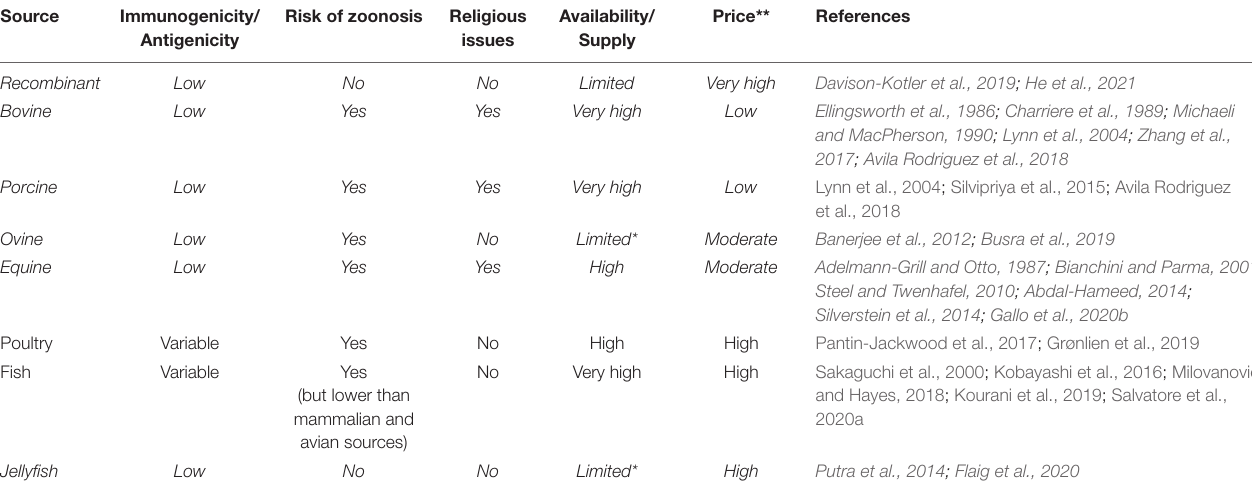
TABLE 4 | Comparison of the main collagen sources utilized and/or investigated for the production of collagen-based scaffolds.